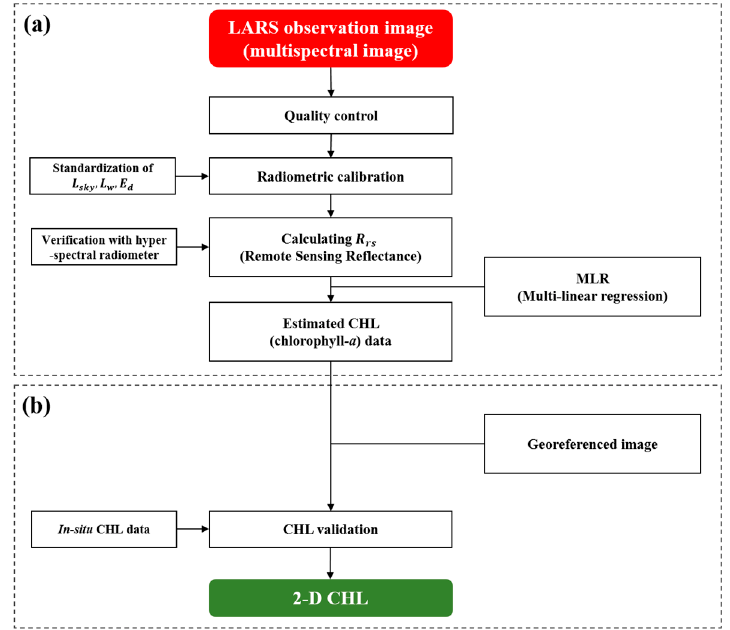
Figure 4. Flowchart for ( a ) calculating the chlorophyll- a concentration (CHL) and applying the CHL algorithm; ( b ) validation parts of the study.